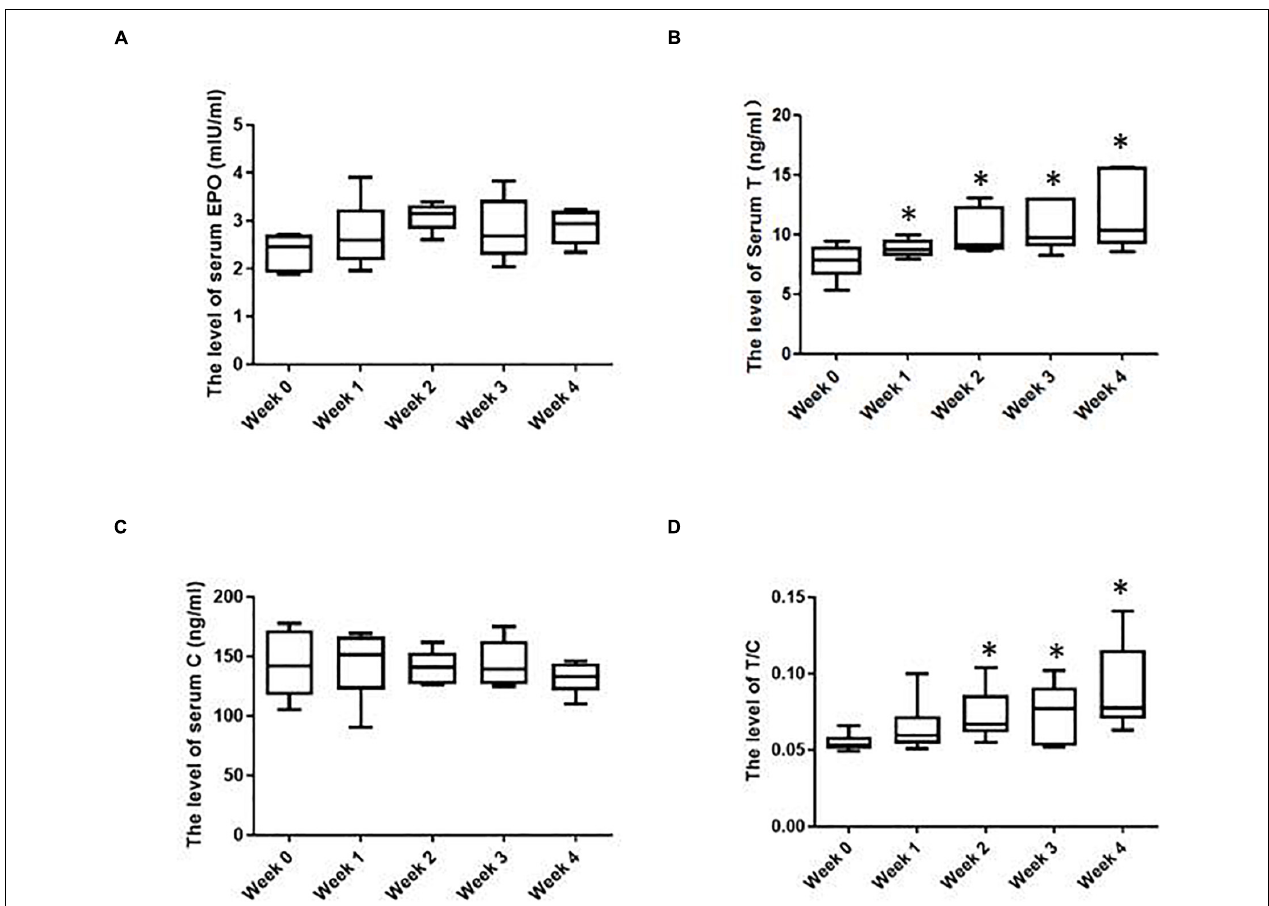
FIGURE 2 | The hormonal parameters of the subjects in various weeks. (A) Serum erythropoietin (EPO) levels; (B) serum T levels; (C) serum C levels; (D) serum T/C levels. ∗ Significantly different from week 0, P <